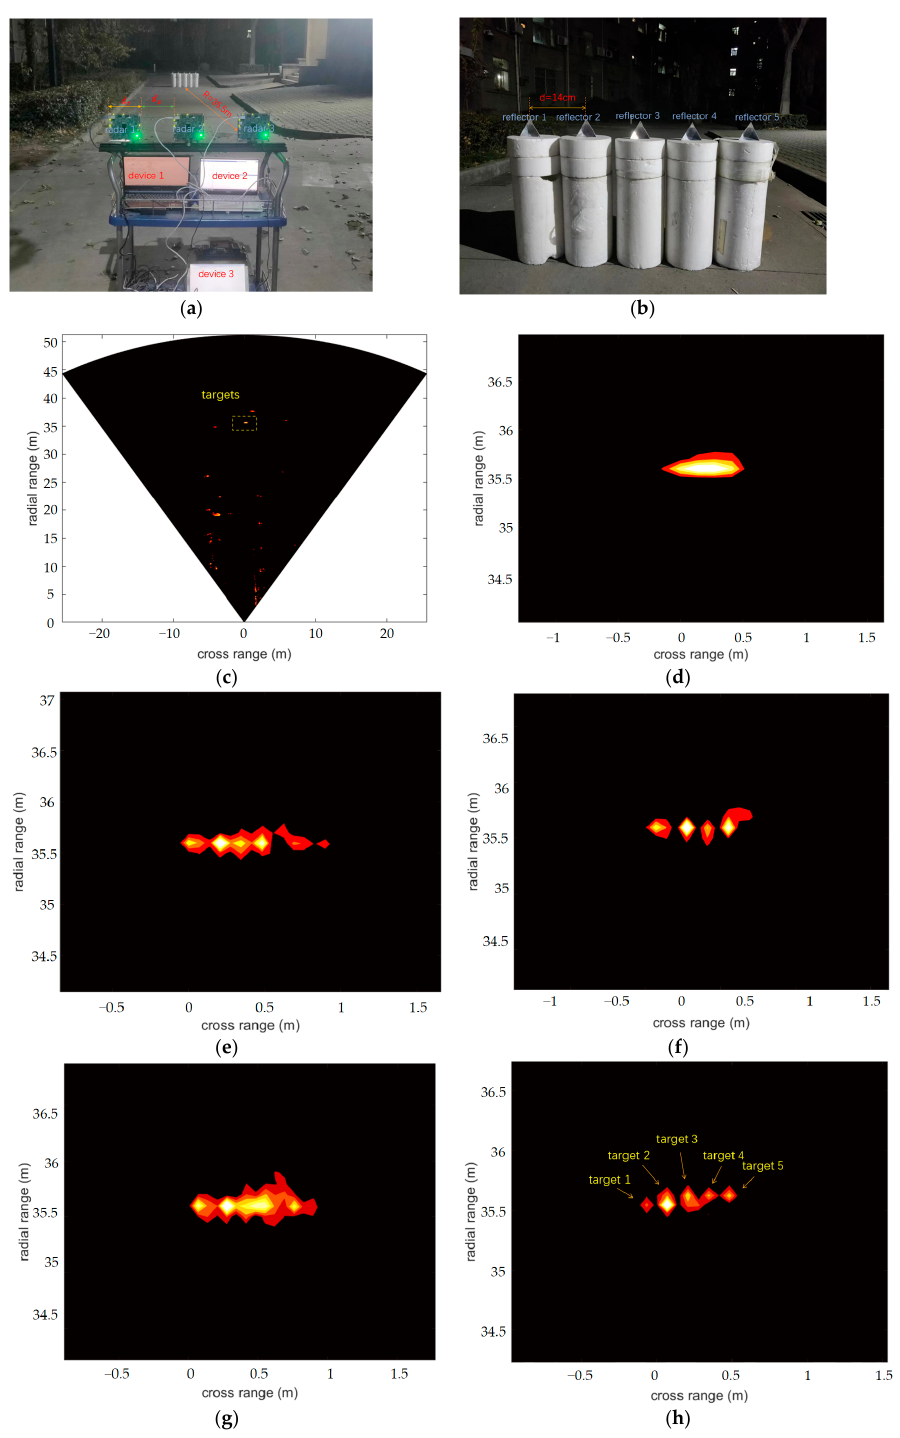
Figure 6. Scene one: ( a ) photograph of distributed radar system, ( b ) photograph of five corner reflectors, ( c ) single-radar SBL imaging result. Zoomed-in imaging of targets with the single-radar system and SBL algorithm ( d ), the distributed radar system and FIAA algorithm ( e ), the distributed radar system and OMP algorithm ( f ), the distributed radar system and S-ESBL algorithm ( g ) and the distributed radar system and LC-SBL algorithm ( h